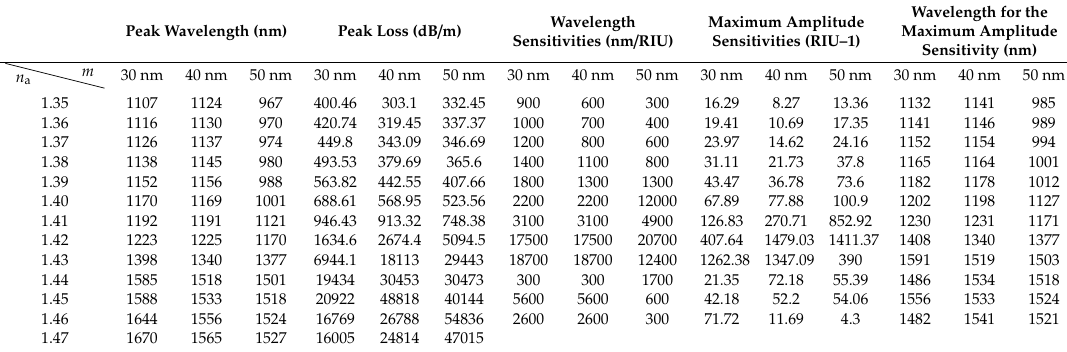
Table 1. Comparison of the sensing parameters of the x -even core modes at the n a range of 1.35–1.47 for m values of 30, 40, and 50 nm, respectively. Peak Wavelength (nm) Peak Loss (dB /